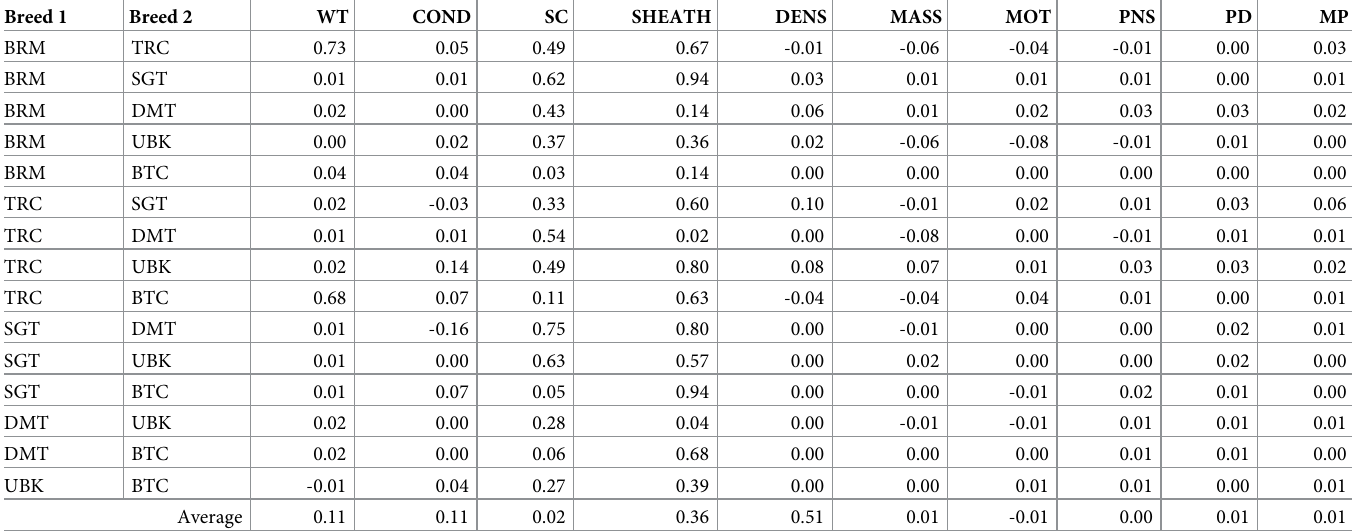
Table 2. Estimates of genomic correlation within phenotype across all pair wise